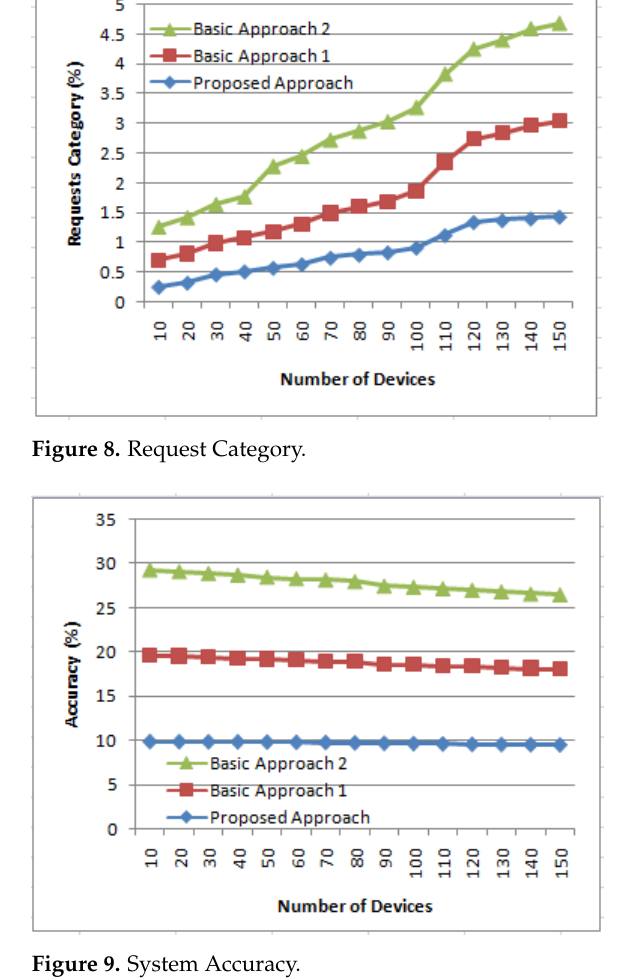
Figure 9. System